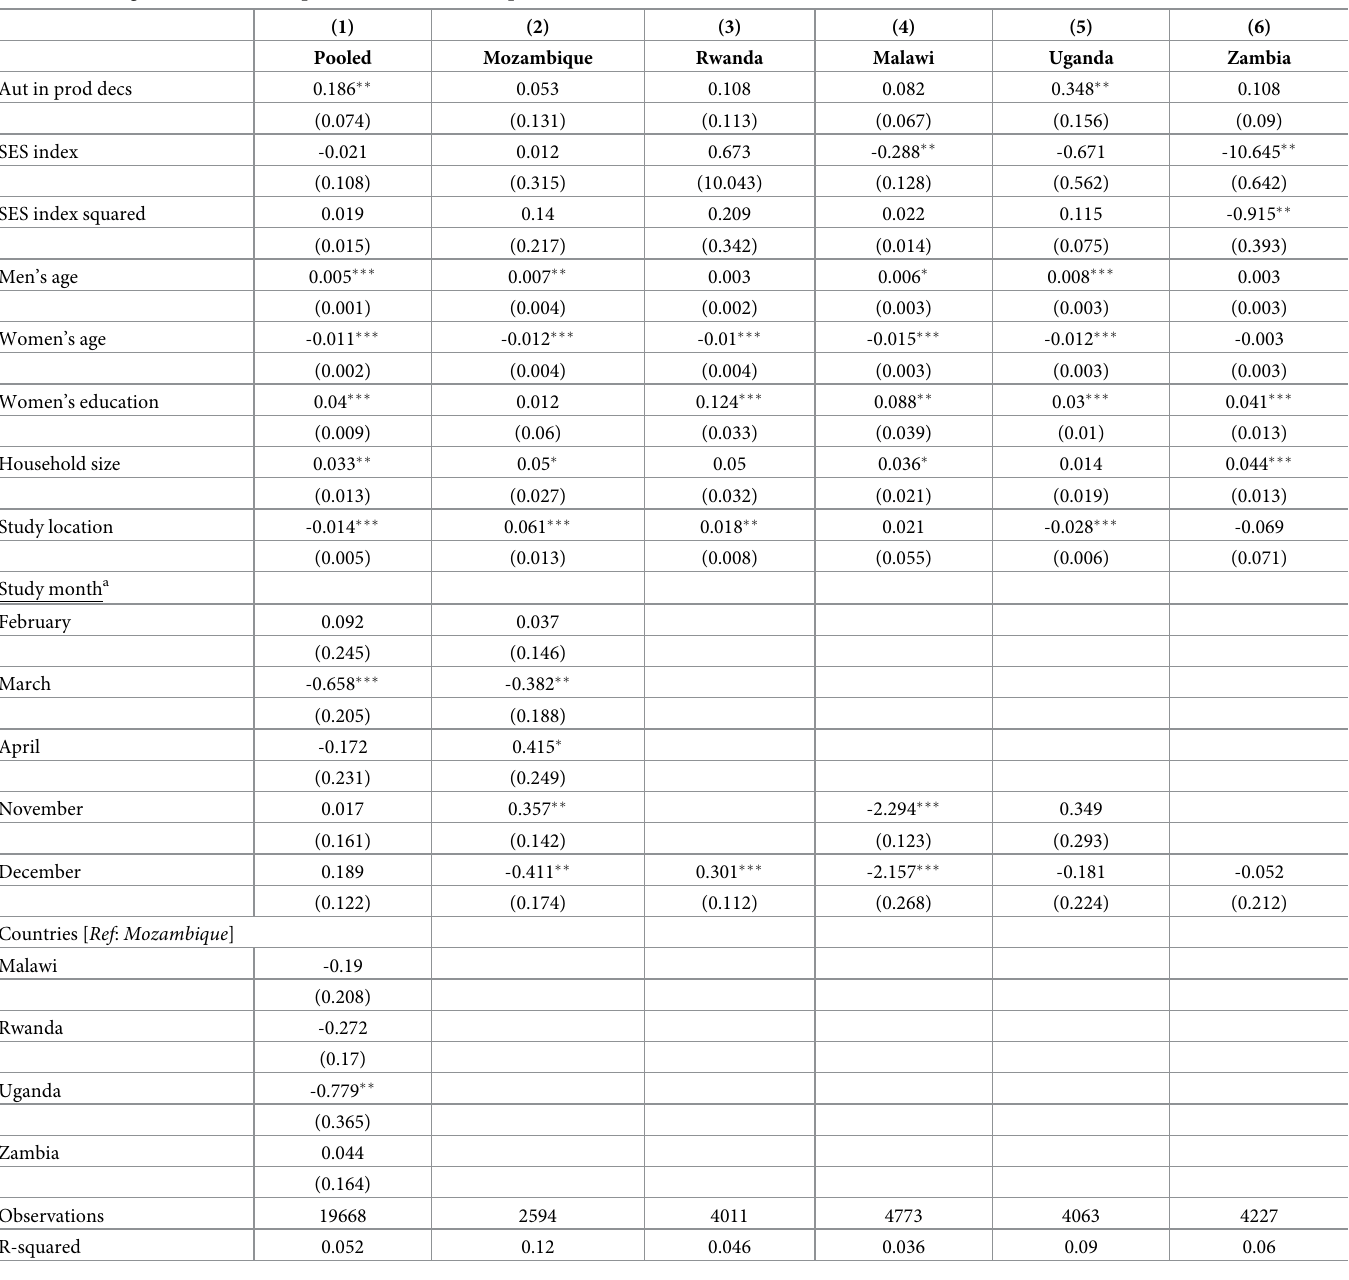
Table 5. OLS regression for WDDS–prod domain (Aut in � 2 production